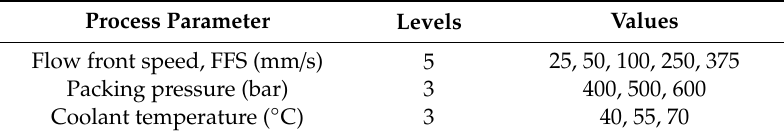
Table 2. Process parameters for the design of experiment